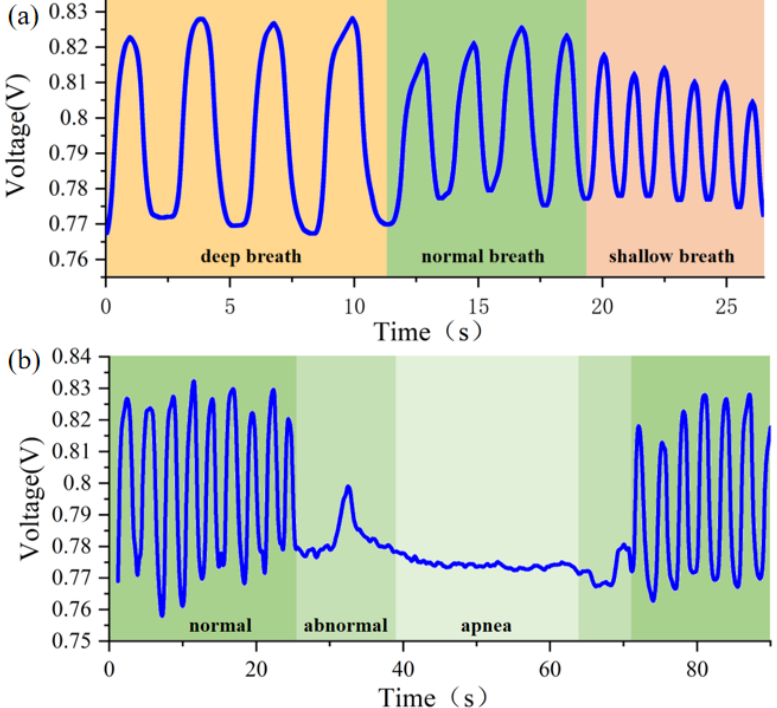
breathing, and the frequency and amplitude of breathing are obviously different from normal breathing.